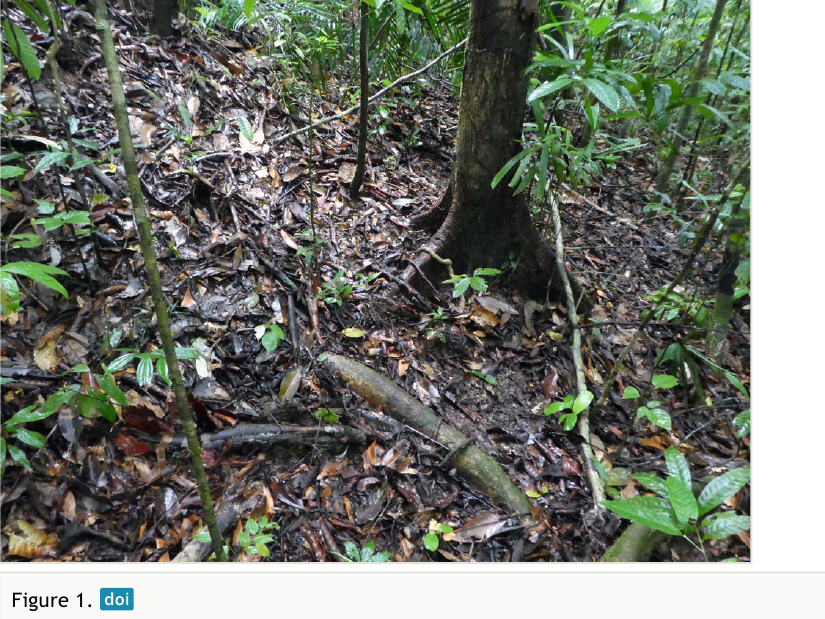
Habitat at the type locality of Clavicornaltica belalongensis n. sp. near Kuala Belalong Field Studies Centre. The species was collected from two microhabitats: leaf litter on the forest fl oor and between buttress